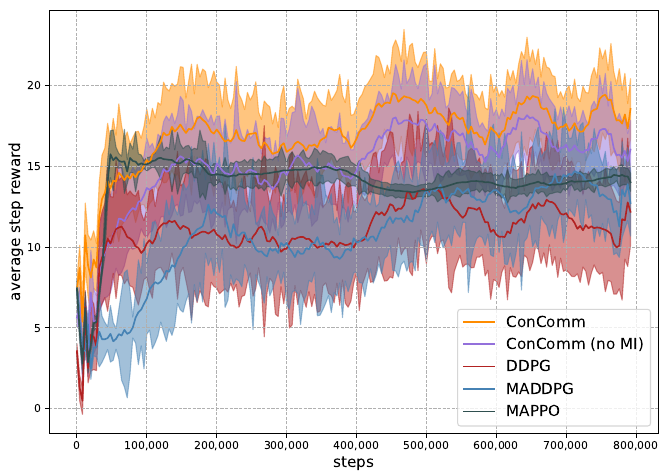
Figure 5. The performance of different algorithms in the execution phase. Performance during Execution After training, we fix the network parameters and compare the performance of different algorithms in the simulation environment without exploration. The results are shown in Figure 6. In this figure, the height of each bar represents the sensing reward, where the red part is the battery penalty, and the blue part is the true average reward, which equals the sensing reward minus the battery penalty. The algorithm with the highest blue bar has the best performance.